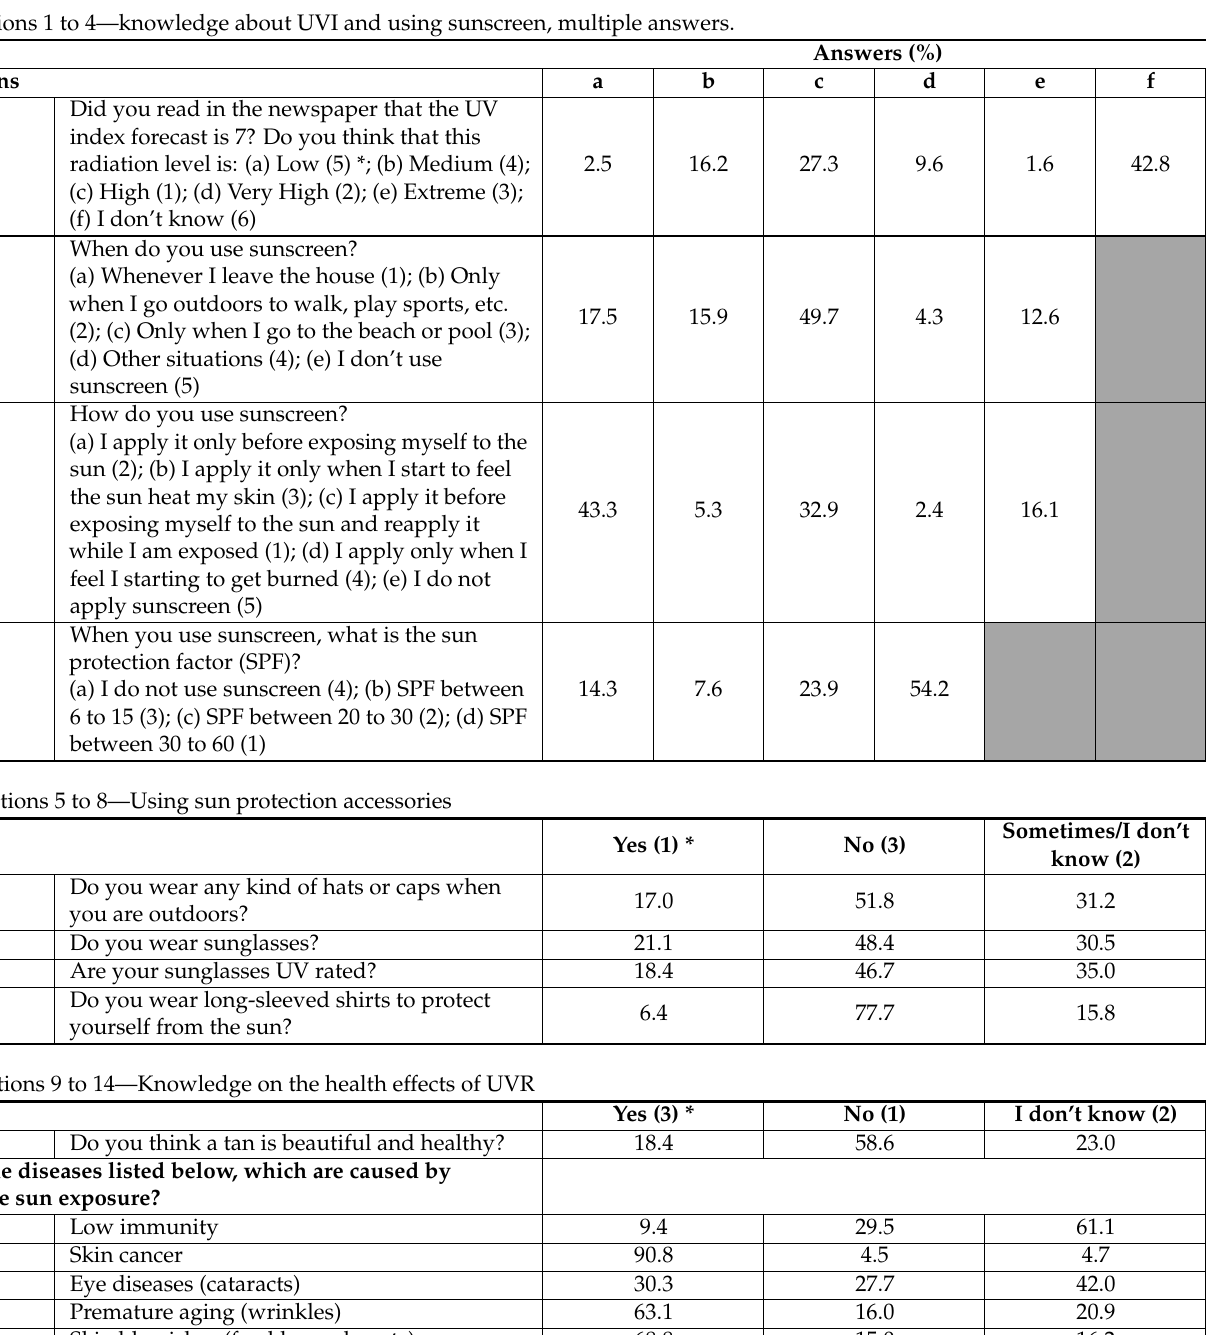
Table 4. Questions and answers on knowledge and habits for